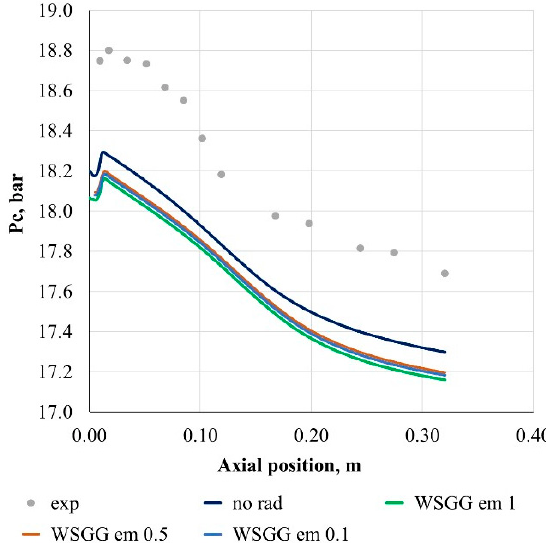
Figure 30. Pressure axial distribution.